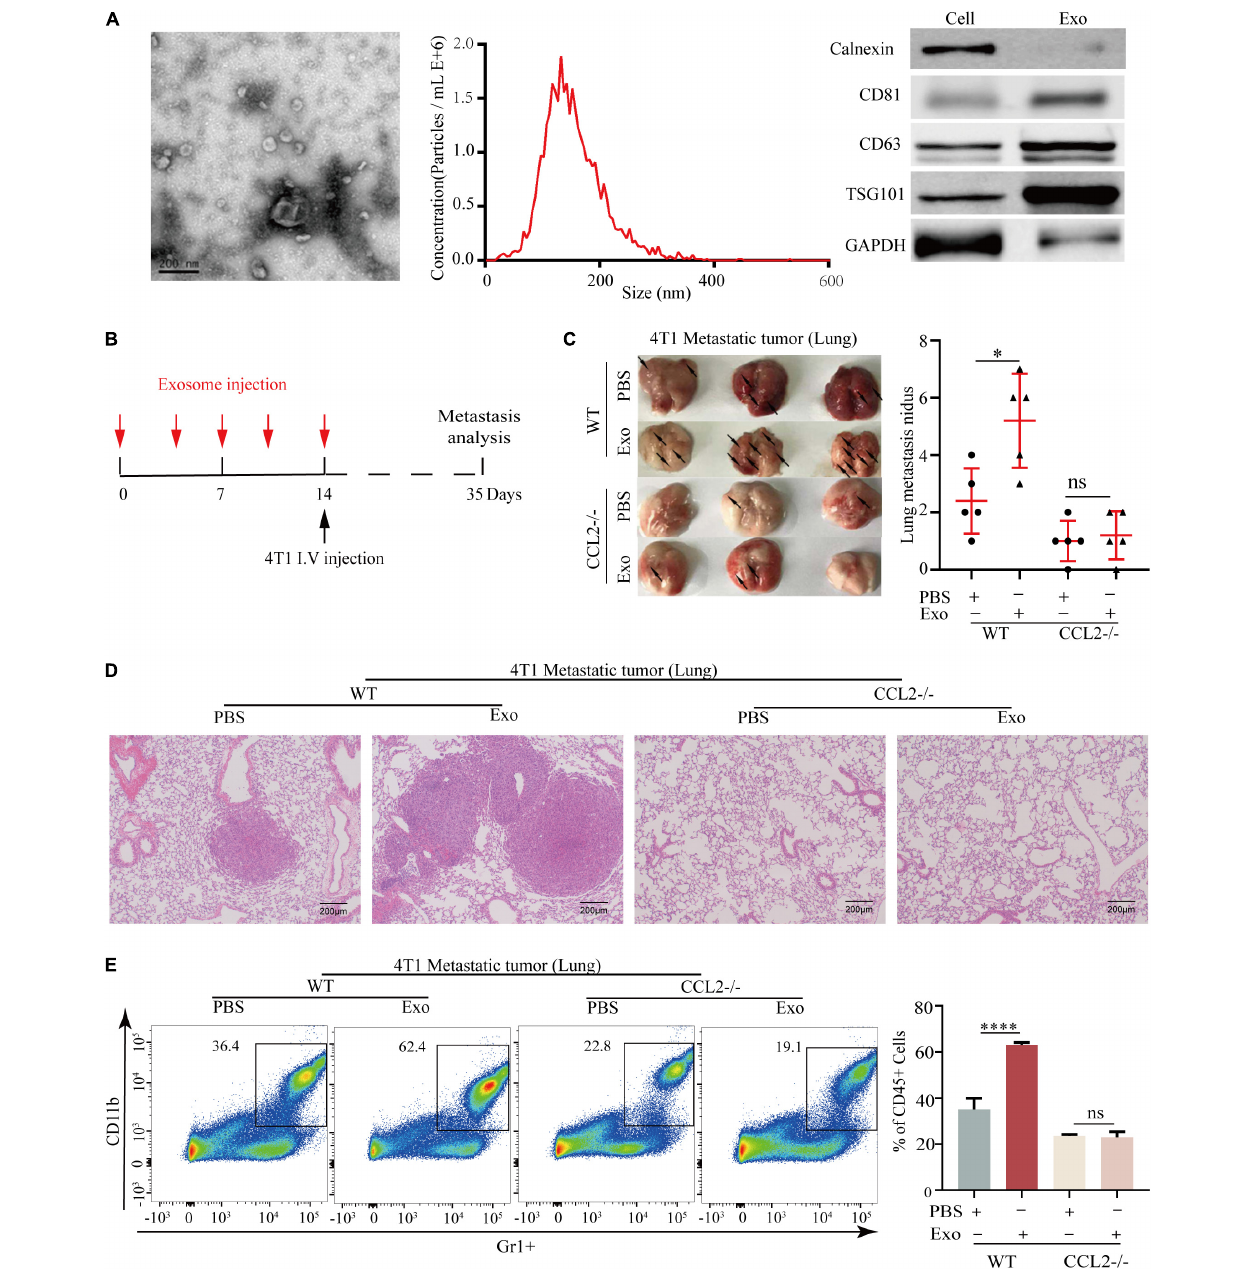
FIGURE 3 | Breast tumor-derived exosomes promote breast cancer metastasis via CCL2-dependent manner. (A) Electron microscopic identification (left) and nanoparticle tracking analysis (middle) of 4T1 derived exosomes. Western blot analyses of exosomal markers Calnexin, CD63, CD81, TSG101, and GAPDH in 4T1 cells and 4T1 derived exosomes (right). (B) Schematic illustration for the in vivo 4T1 derived exosomes education and breast cancer lung metastasis analysis. (C) Representative photograph of 4T1 lung metastasis tumor (left) and lung metastasis nidus counts (right) in both WT and CCL2–/–mice educated with tumor-derived exosomes or PBS ( n = 5). (D) Representative hematoxylin-eosin staining of lung metastasis tumor in both WT and CCL2–/– mice educated with 4T1 derived exosomes or PBS. Bar = 200 µ m (magnification: 100 × ). (E) Analysis of MDSCs recruitment in the lung of both and CCL2–/– mice educated with tumor-derived exosomes or PBS by FACS ( n = 5). P values were calculated by unpaired Student’s t -test (* P < 0.05, **** P <